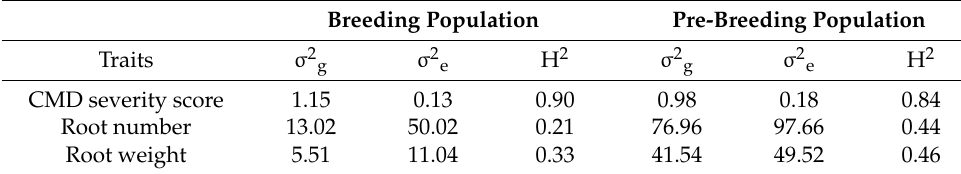
Table 3. Broad-sense heritability calculated on a mean plot basis for cassava mosaic disease (CMD) severity score, root number, and root weight in the clonal evaluation trial